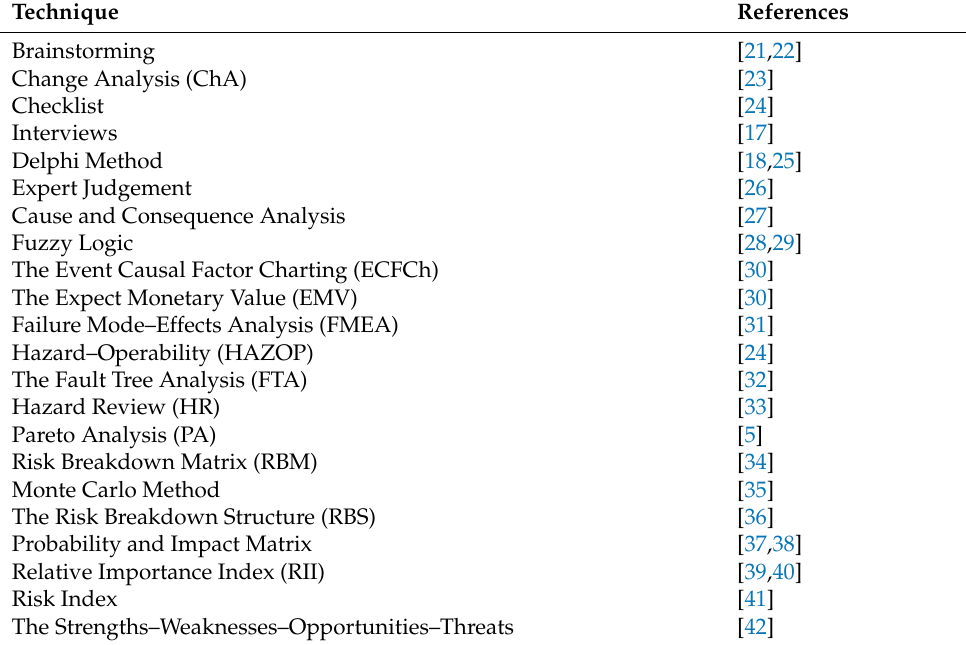
Table 1. Risk management process